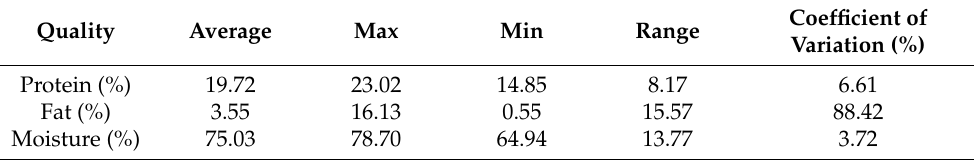
Table 1. Determination of results of moisture content, protein content, and fat content.